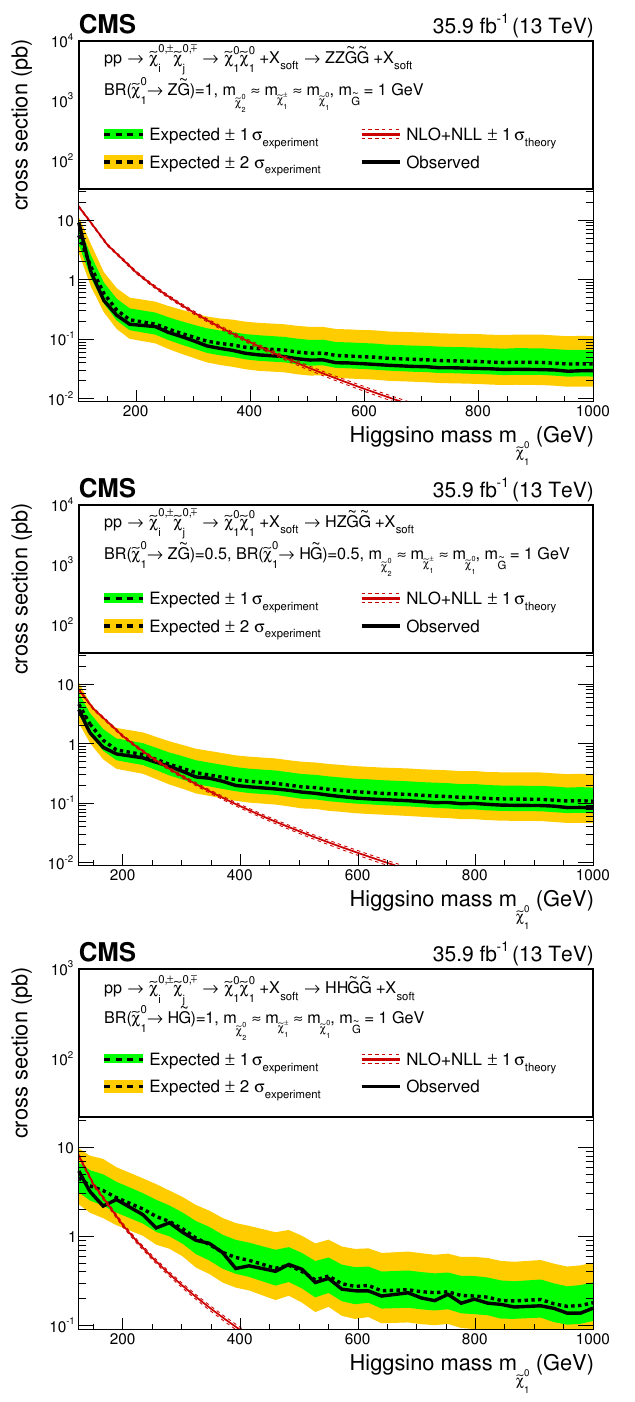
Figure 19 . Interpretation of the results in the model (middle), and the G model (lower) obtained with events of all trilepton (A{F) and all four-lepton (G{K) categories. The observed, median expected, (cid:6) 1 (cid:27) experiment expected, and (cid:6) 2 (cid:27) experiment expected 95% CL upper limit on the neutralino pair production cross section are compared to the NLO+NLL cross sections (cid:6) 1 (cid:27) theory